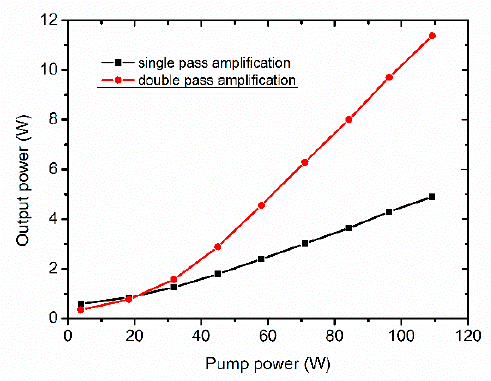
Figure 3. Output power of single ‐ and double ‐ pass amplification of the first stage SCF amplifier.